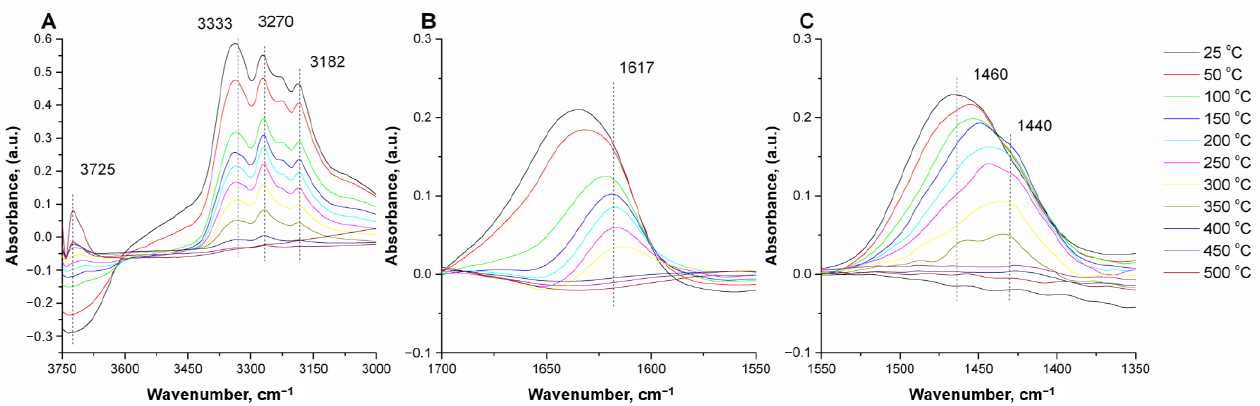
Figure 6. DRIFT spectra for Cu/Y/s catalysts during NH 3 dynamic sorption experiments in different wavenumber regions: ( A ) 3000–3750 cm − 1 , ( B ) 1550–1700 cm − 1 and ( C ) 1350–1550 cm − 1 .